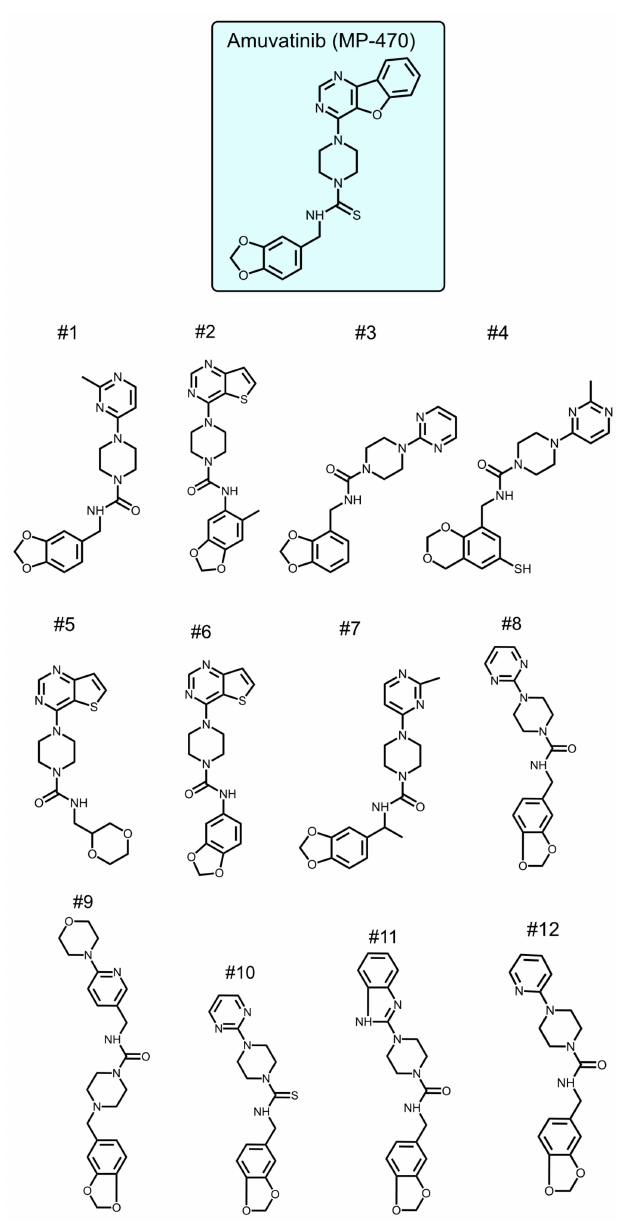
Figure 1. Amuvatinib